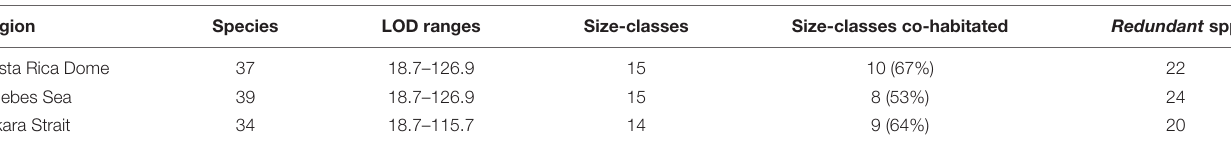
TABLE 3 | Summary of morphological data by region.